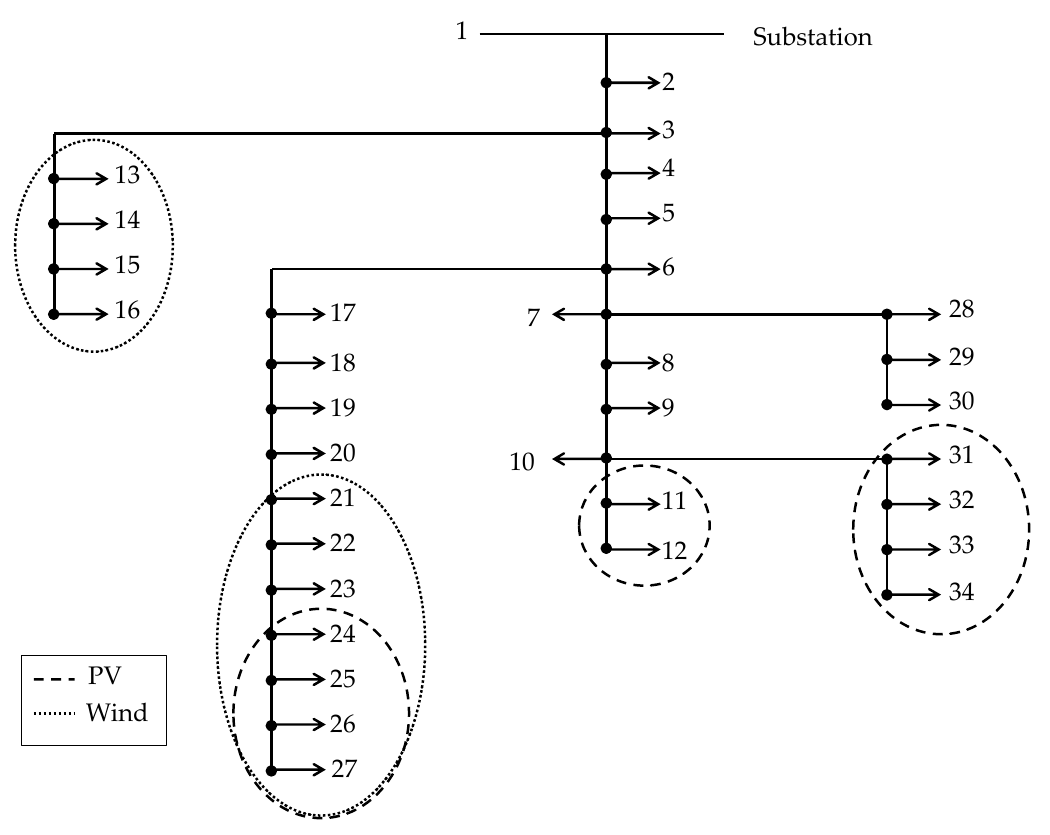
Figure 2. Distribution system under study.